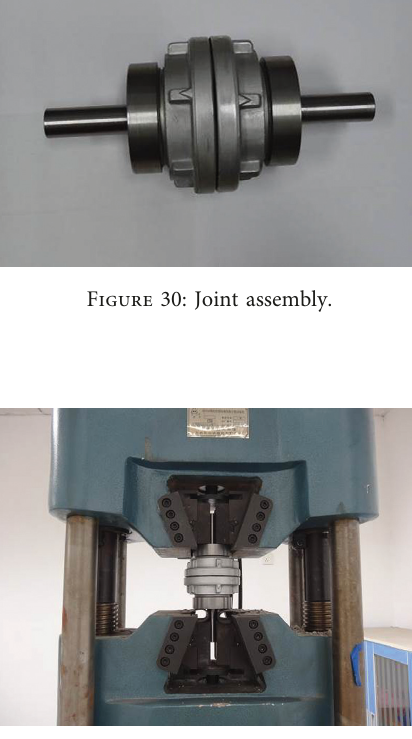
Figure 31: Joint installation.